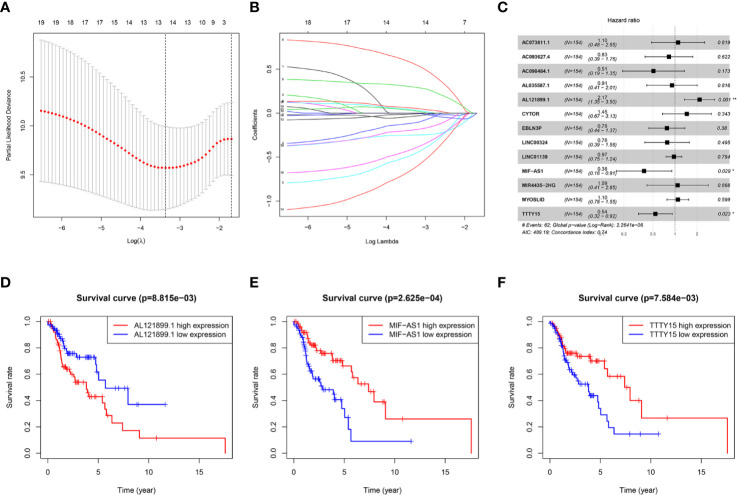
Identification of a three-autophagy-related lncRNA prognostic signature. (A) Partial likelihood deviance was plotted versus log(λ). The vertical dotted line indicates the lambda value with the minimum error and the largest lambda value, where the deviance is within one standard error of the minimum. (B) LASSO coefficient profiles of genes associated with overall survival of head and neck squamous cell carcinoma. (C) Forest plot depicting associations between lncRNAs and risk value determined via multivariate Cox regression analysis. *p < 0.05, **p < 0.01. (D–F) Kaplan–Meier survival curves derived from three autophagy-related lncRNAs and HNSCC patients. These lncRNAs were considered to constitute a prognostic signature for HNSCC. AL121899.1 was identified as a negative prognostic factor, and TTTY15 and MIF-AS1 were identified as positive prognostic factors. (D) AL121899, (E) MIF-AS, (F) TTTY15.